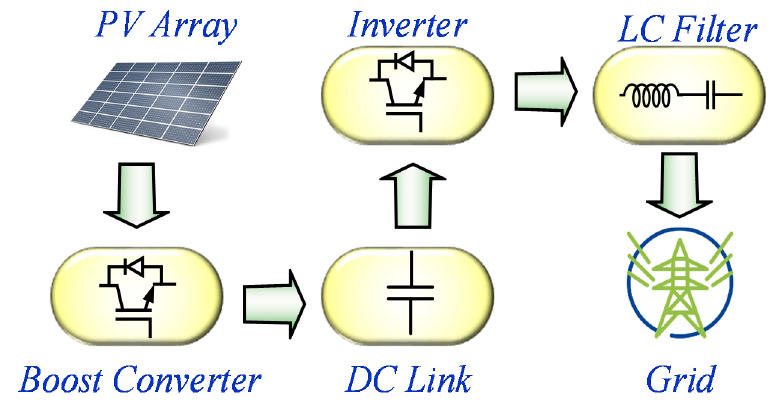
Figure 3. Block diagram of converter and inverter-based on solar PV system.